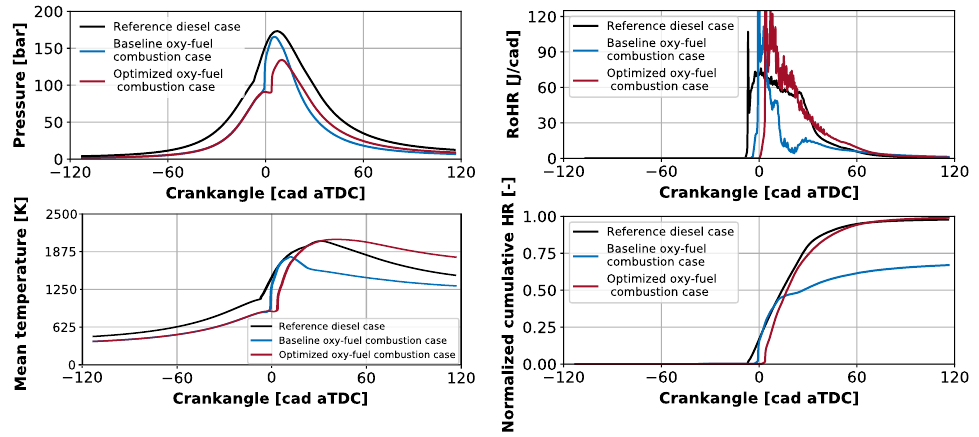
Figure 14. Comparison between in-cylinder pressure, RoHR, and normalized cumulative HR for the reference diesel case, baseline, and optimized oxy-fuel combustion